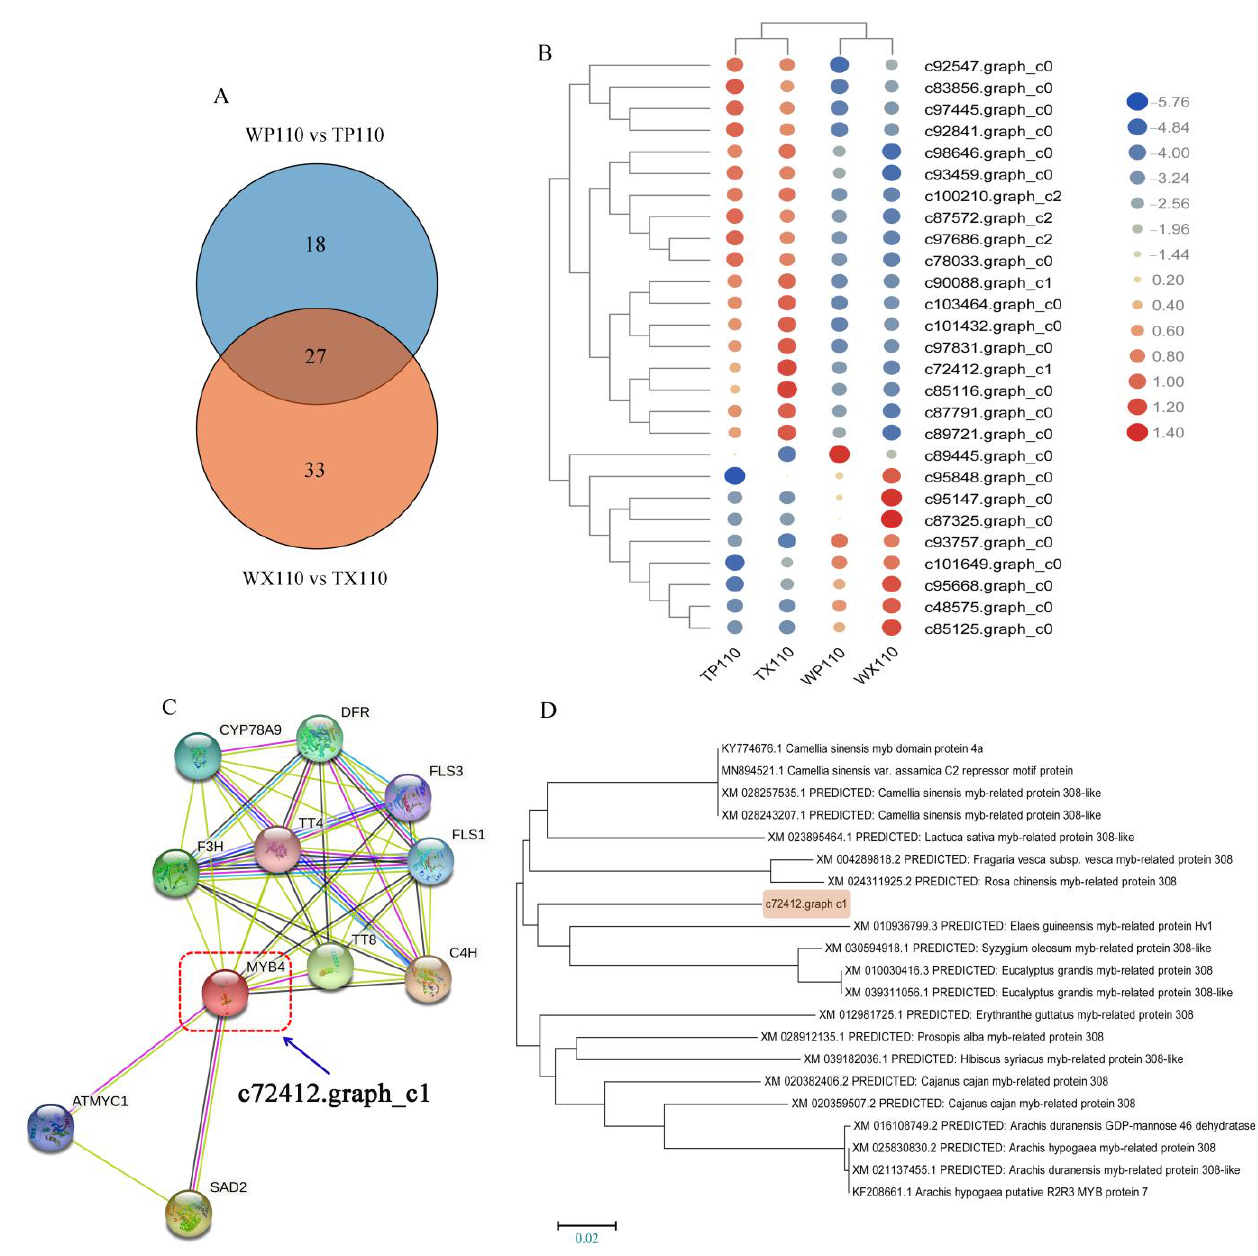
Figure 3. The possible MYB-related genes involved in light-inducible fruit coloration. ( A ) Venn diagram of MYB-typed DEGs between WP110 vs. TP110 and WX110 vs. TX110. ( B ) The transcription level of 27 MYB-typed DEGs. ( C ) The analysis of functional protein association networks in Arabidopsis for MYB4 as the closest ortholog available of c72412.graph_c1. ( D ) Phylogeny analysis of c72412.graph c1 and its top 20 homologous genes in NCBI blast. The way of phylogenetic tree construction is Construct/Test Neighbor-Joining Tree in MEGA 6.0 software (Version 6.0, Mega Limited, Auckland, New Zealand). The orange shadow mutates the transcript c72412.graph c1. The setting bar for genetic distance is 0.02.